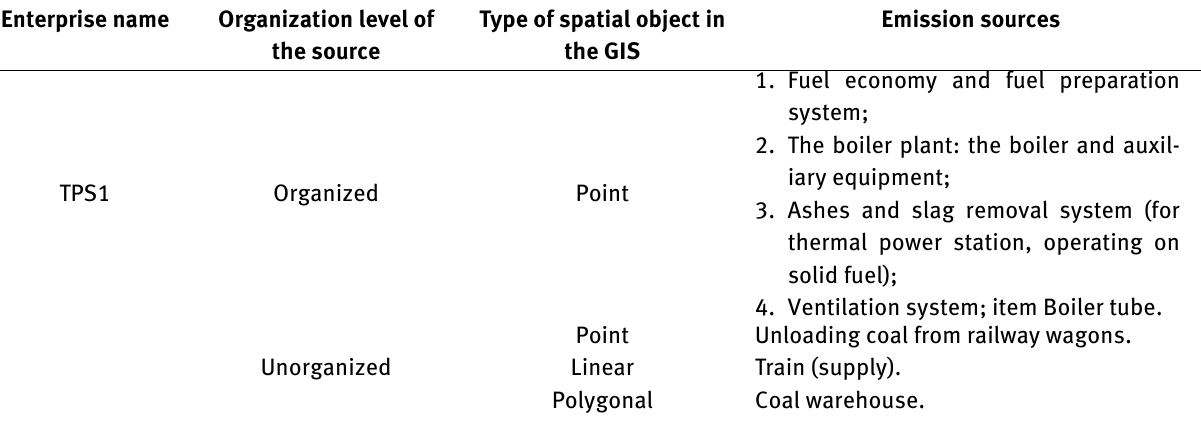
Table 1: Characteristics of the source of emissions in the atmosphere on the example of Almaty